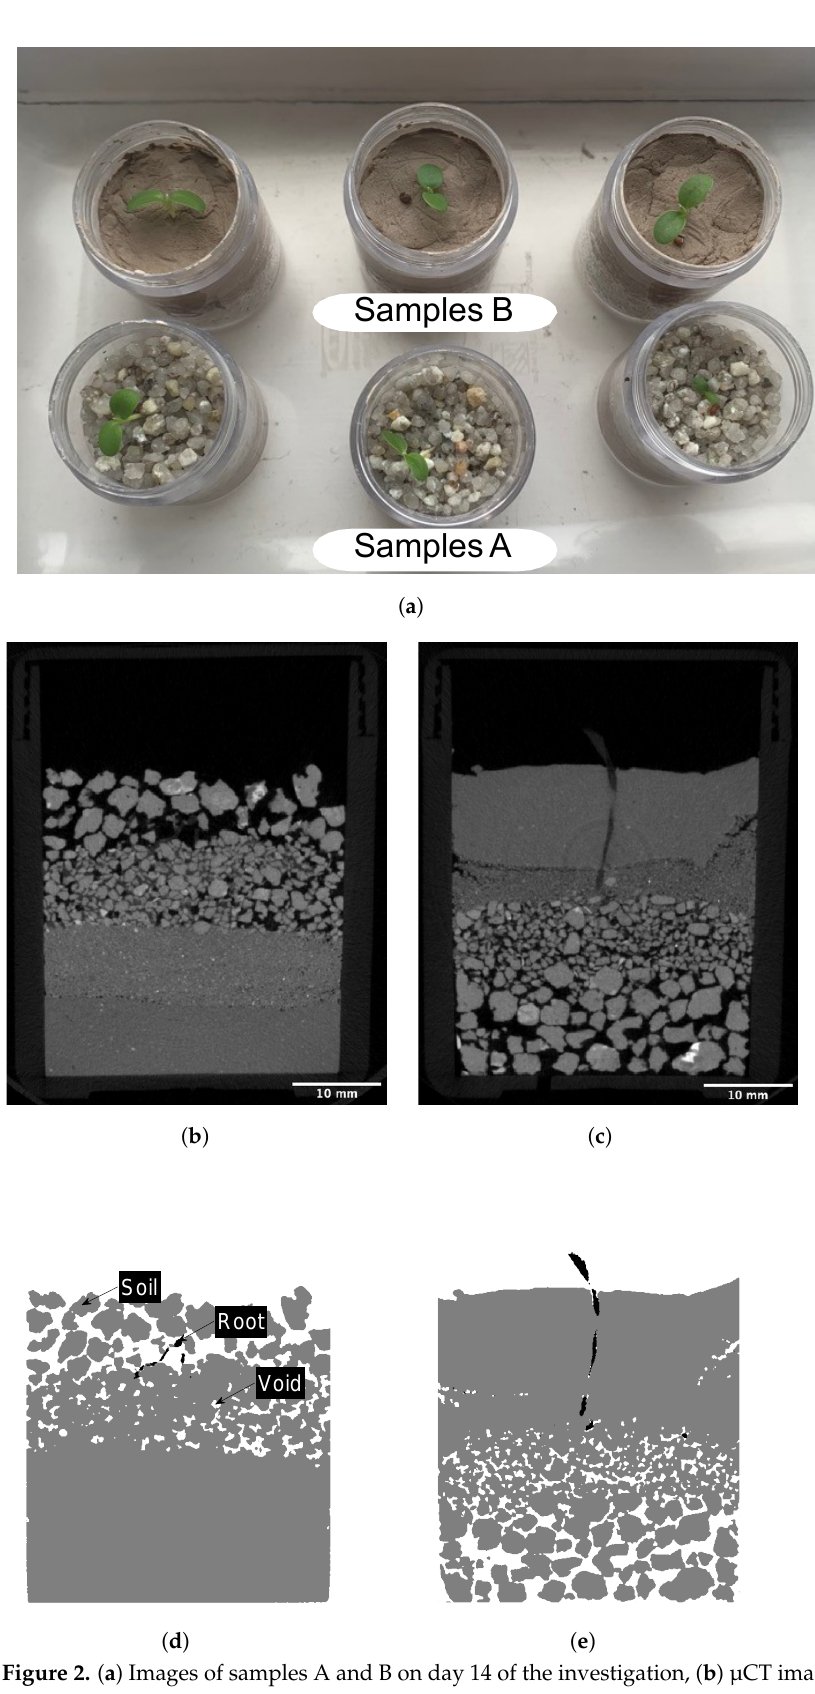
Figure 2. ( a ) Images of samples A and B on day 14 of the investigation, ( b ) µCT image reconstruction cross-section of sample A, day 15, ( c ) µCT image reconstruction cross-section of sample B, day 15. ( d ) labelled image of Sample A, ( e ) labelled image of Sample